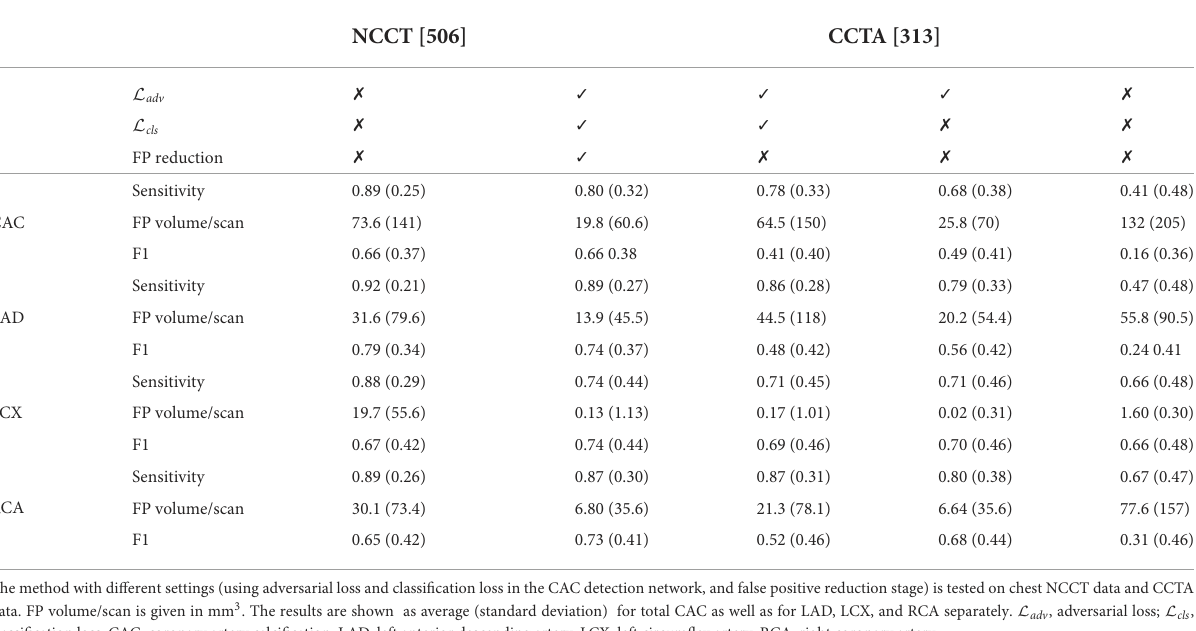
TABLE 2 Results of the automatic CAC scoring evaluated by volume-wise sensitivity, FP volume per scan, and F1-score between automatic detection and manual reference.